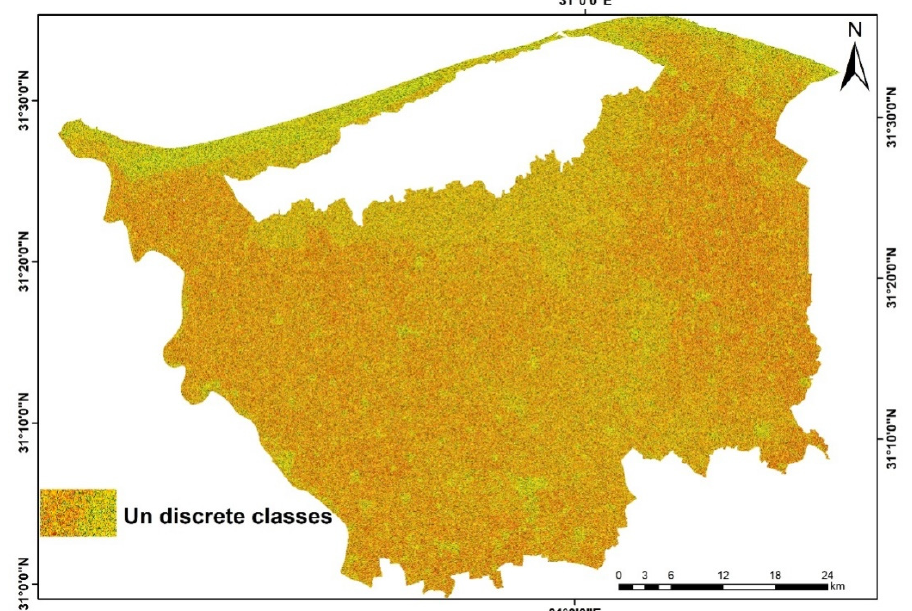
Figure 11. A 2002 map showing the SAfSoil results from the indices of Dehni and Lounis [74].